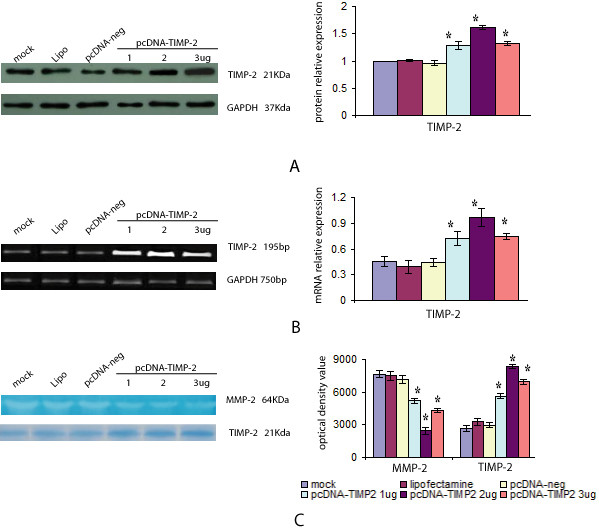
Overexpression of TIMP-2 inhibited the MMP-2 activity of ameloblastoma cells. Ameloblastoma cells were transfected with mock, lipofectamine, pcDNA-neg, pcDNA-TIMP-2 (1 μg), pcDNA-TIMP-2 (2 μg), or pcDNA-TIMP-2 (3 μg) for 72 h. GAPDH was included as an internal control to normalize the amounts of protein or mRNA. The relative protein or mRNA level of TIMP-2 was depicted as the ratio of the density of TIMP-2 to GAPDH for the same time point. The results are a representative experiment among three. *Compared with the mock, lipifectamine or vector controls, respectively, p < 0.05. (A) Western blotting (WB) was used to detect TIMP-2. TIMP-2 protein levels increased in ameloblastoma cells after transfection with pcDNA-TIMP-2. (B) RT-PCR was used to detect the transcription of TIMP-2 after pcDNA-TIMP-2 transfection. Transcript levels of TIMP-2 in TIMP-2-transfected cells were significantly higher compared with cells transfected with mock and lipofectamine and pcDNA-neg. (C) Zymographic analysis for MMP-2 and TIMP-2 activity in the conditioned medium of ameloblastoma cells transfected with various doses of pcDNA-TIMP-2. The zymography assay revealed that pcDNA-TIMP-2 transfection decreased MMP-2 activity. The inhibition rates were 31.88, 67.87, and 43.57% for 1, 2, and 3 μg, respectively. Reverse gelatin zymography showed that pcDNA-TIMP-2 transfection increased TIMP-2 activity.